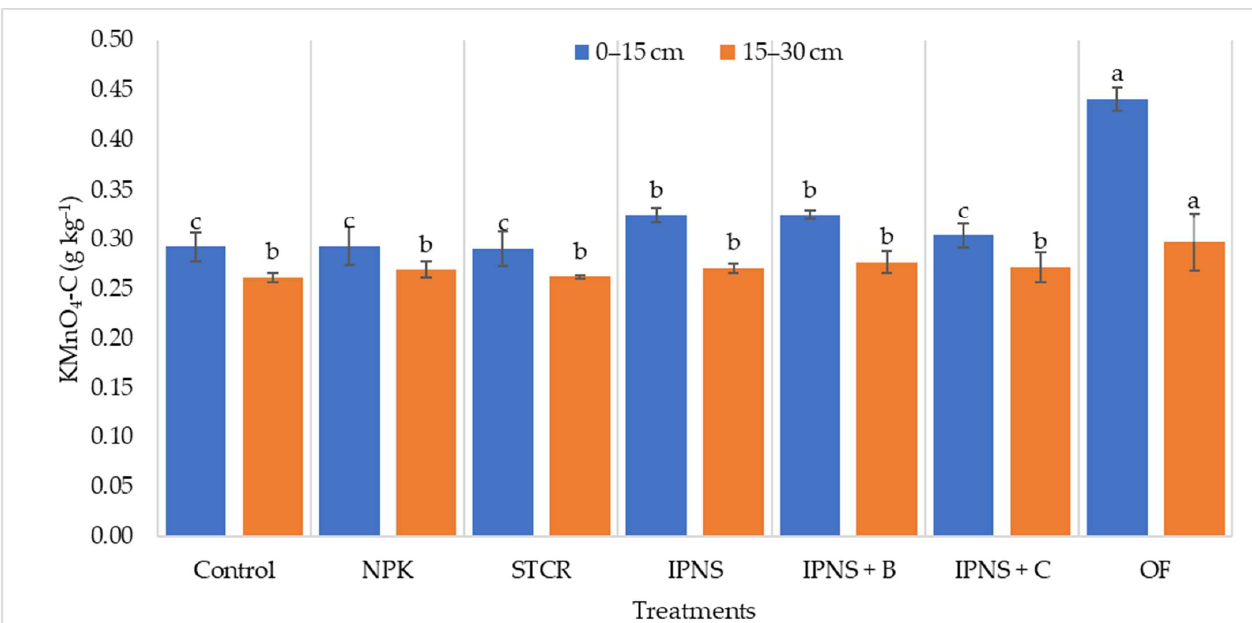
Figure 6. Effect of nutrient management on KMnO 4 -C. Means ± standard deviation of different treatments followed by the different lower-case letter (a–c) are significantly different at p < 0.05 level of significance according to DMRT.